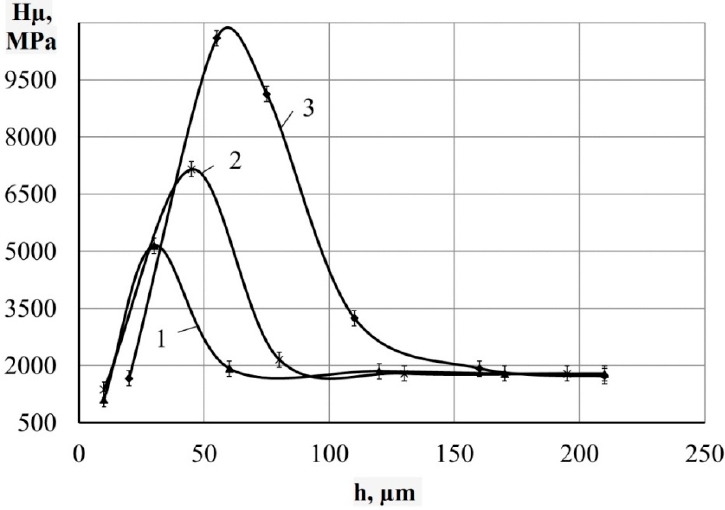
Figure 3. Distribution of microhardness in the surface layer of steel C22 after sulfomolybdenizing by ESA method. On graph: 1—Wp = 0.13 J; 2—Wp = 0.55 J; 3—Wp = 3.4 J.